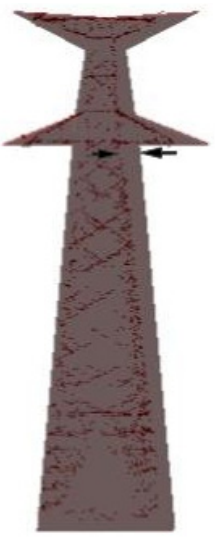
Figure 10. Reconstruction gap caused by pylon inclination.